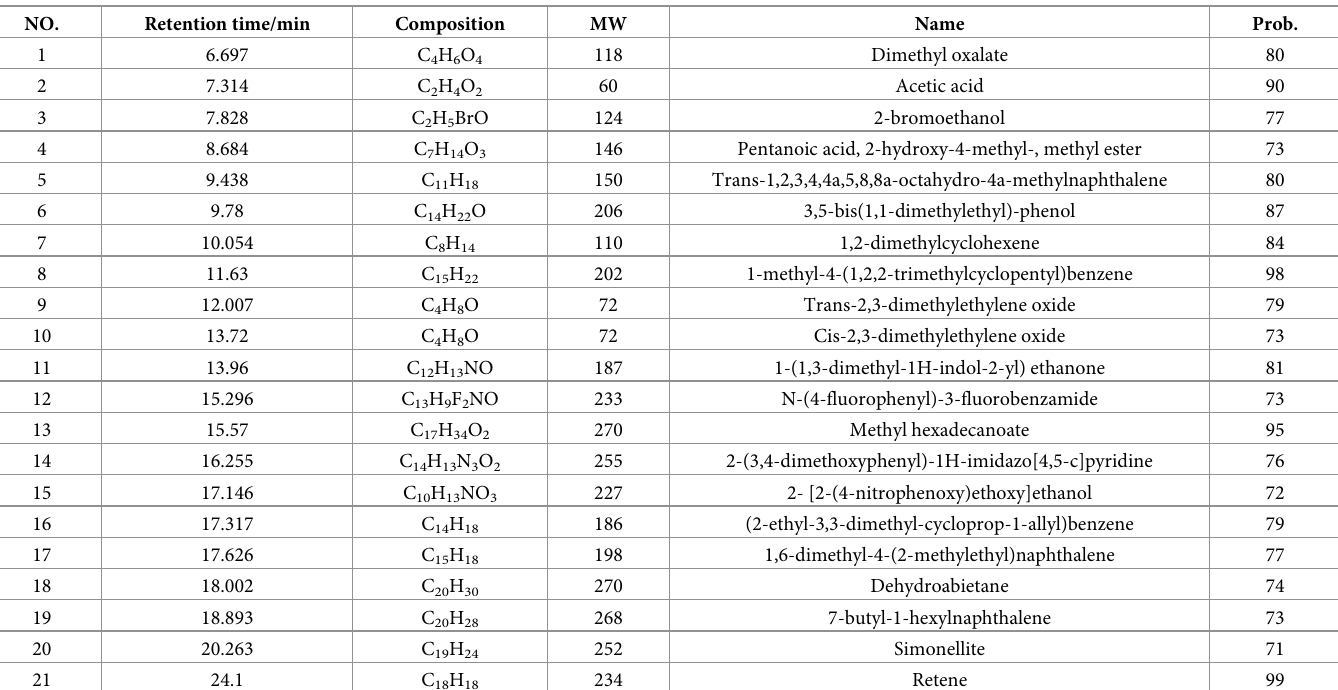
Table 1. Identified molecular compounds in methanol extract.